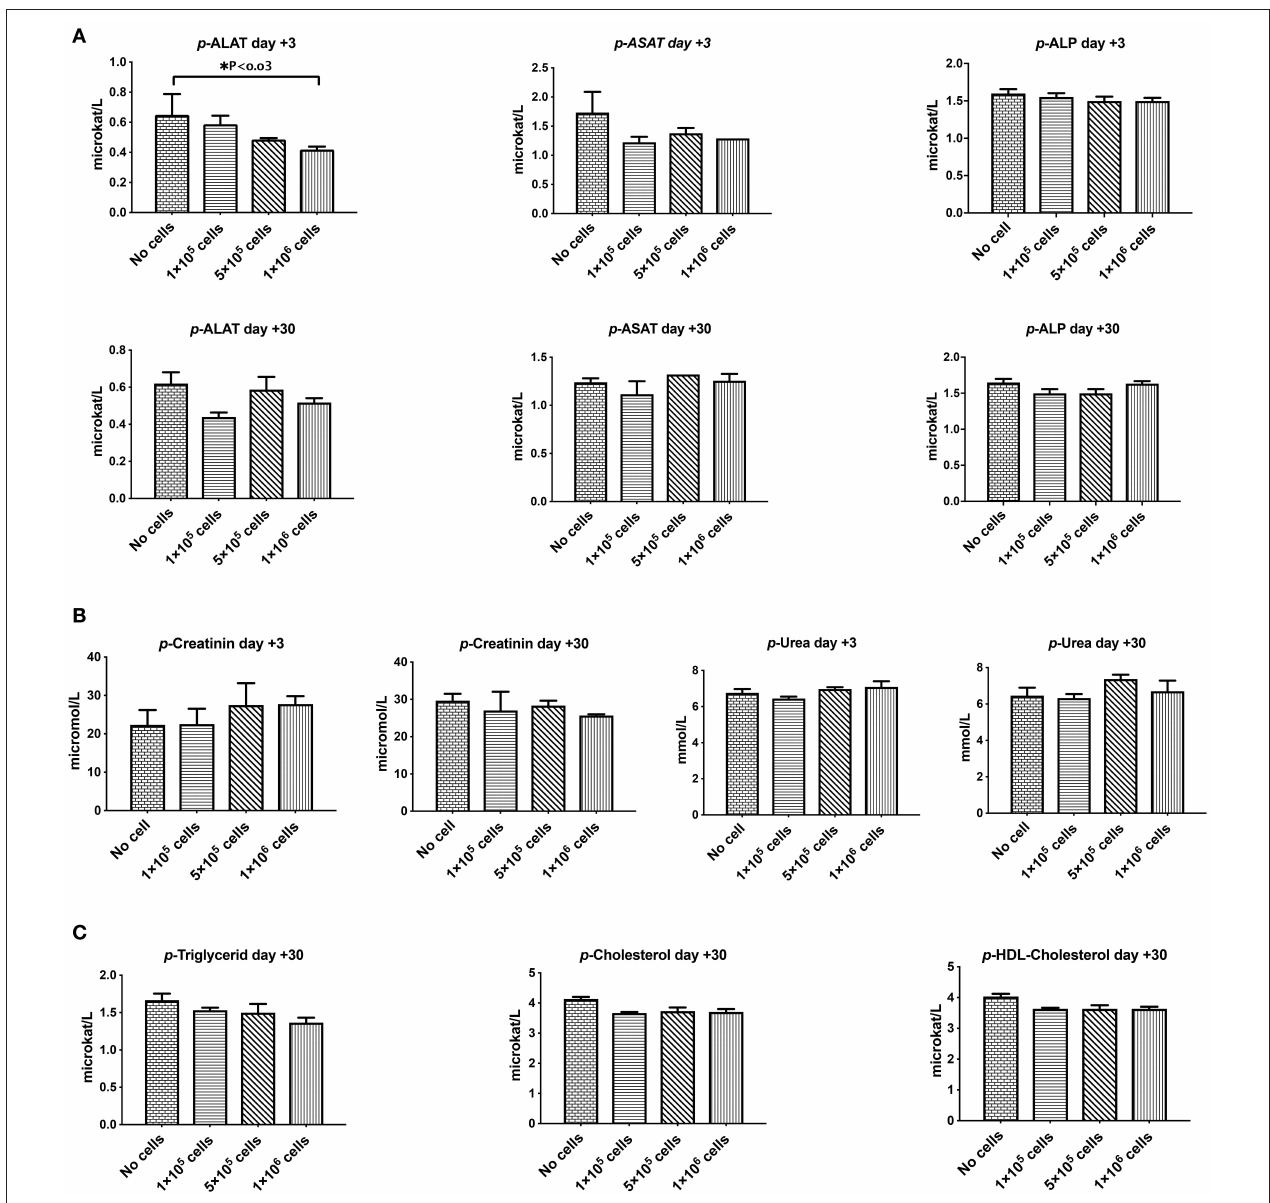
FIGURE 4 | The effect of human DSCs infusion on the liver and kidney function. Organ toxicity is one of the most important concerns in all cell based therapy protocols. Healthy mice received human DSCs i.v. at different doses (0–1 × 10 6 cell/mouse) ( N = 3–5 mouse per dose/timepoint). (A) Liver enzymes (B) kidney function biomarkers and (C) serum lipid profile were measured and compared among different group in short and long term following cell infusion. Interestingly, human cell infusion ranged from 0–40 × 10 6 cell/kg and did not show any toxicity relevant to these organs. plasma levels of cholesterol and triglyceride were observed at day + 30 ( Figure 4C